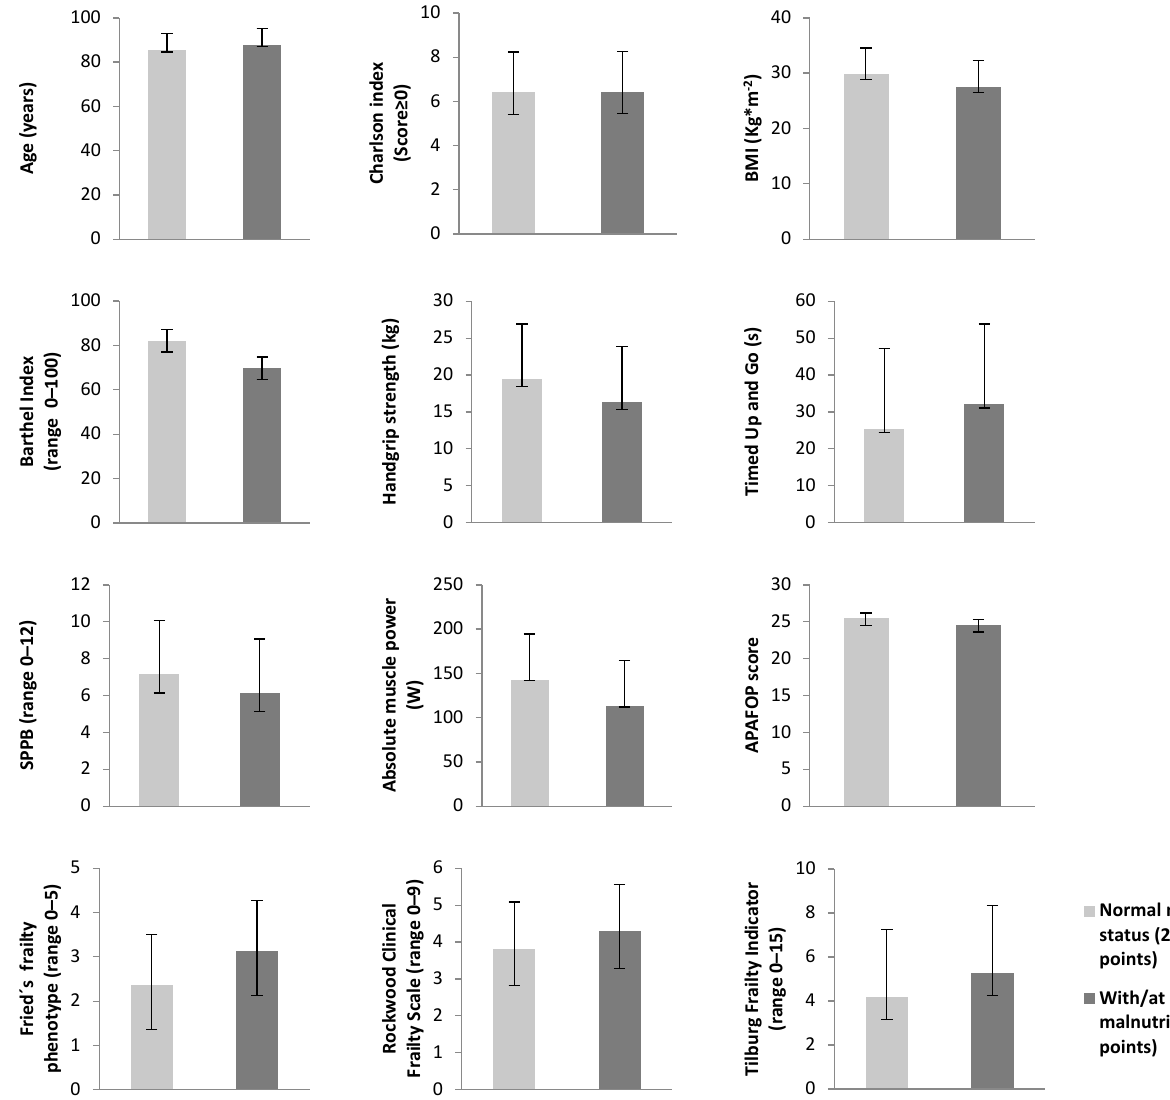
Figure 2. Characteristics of the participants according to the MNA classification (normal nutritional status vs. risk and malnutrition status). MNA: Mini Nutritional Assessment; BMI: body mass index; SPPB: Short Physical Performance Bat ‐ tery; APAFOP: Assessment of Physical Activity in Frail Older People. * p < 0.05 ** p < 0.01 *** p < 0.001.